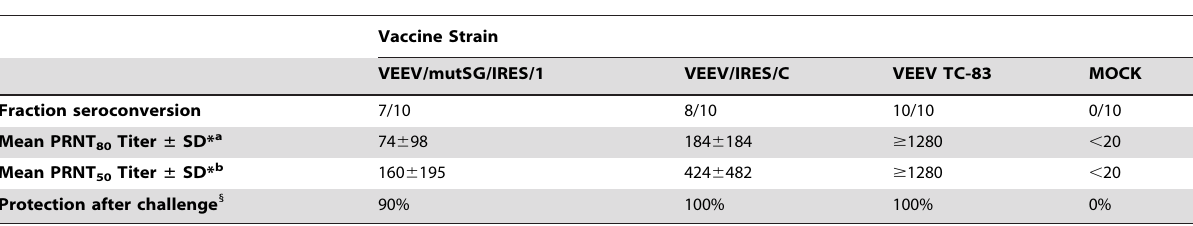
Table 3. Seroconversion of adult mice after